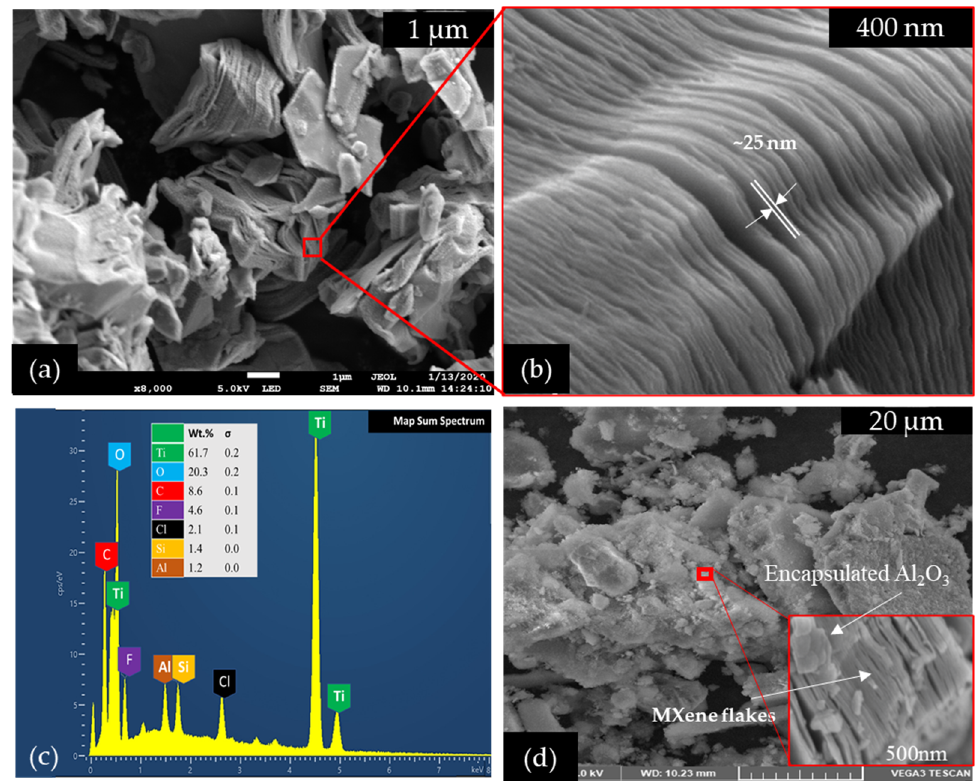
Figure 2. SEM of: ( a ) synthesized MXene at low magnification; ( b ) layered structure of MXene nanosheets at high magnification; ( c ) EDX analysis of the MXene; ( d ) SEM of MXene + Al 2 O 3